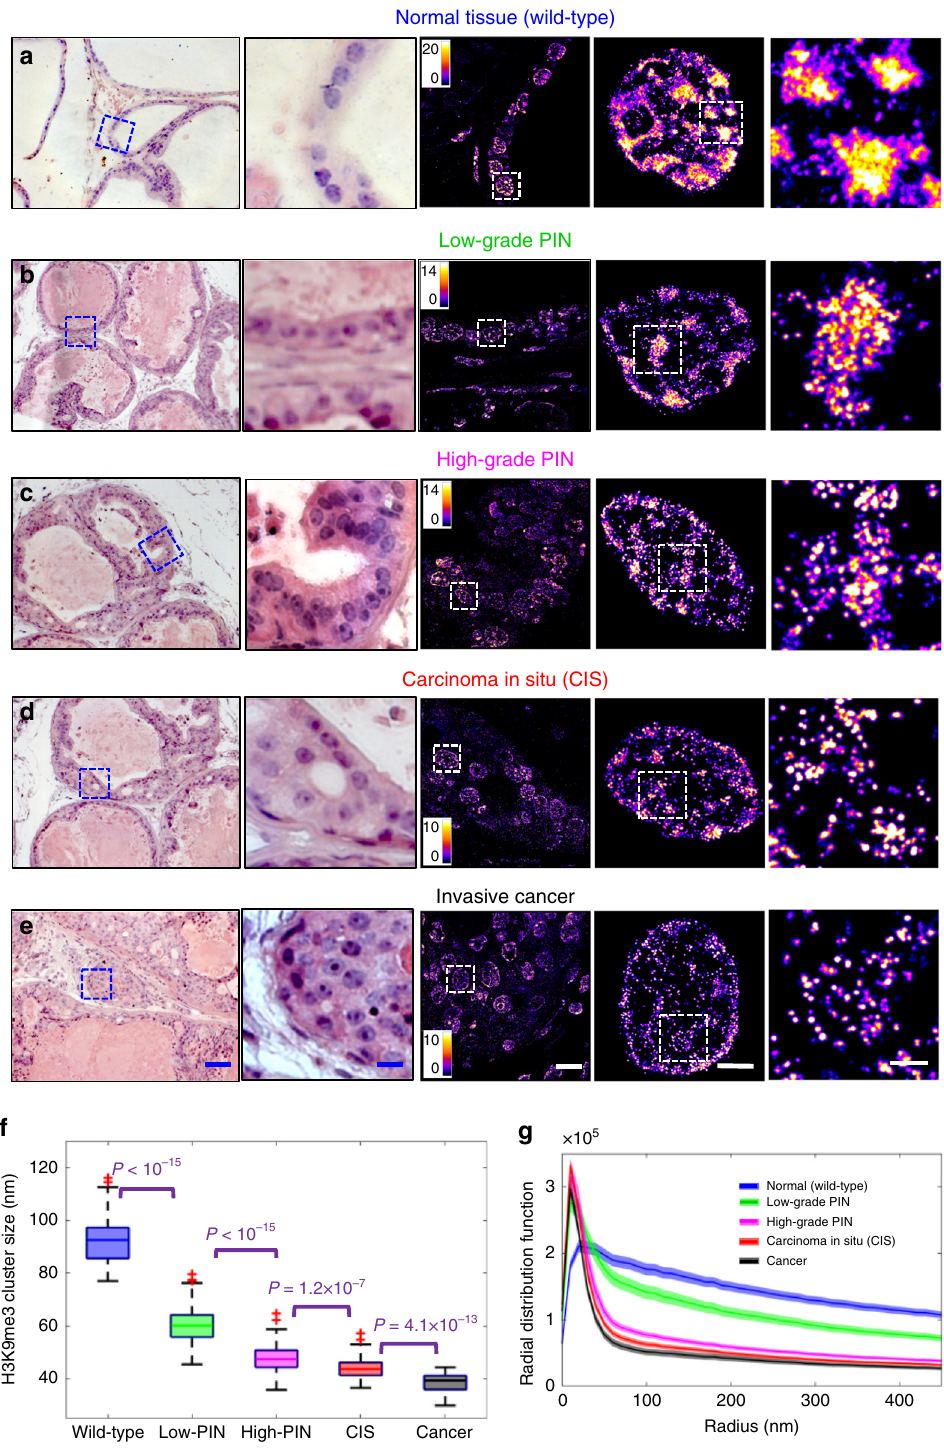
Fig. 5 Super-resolution imaging of disrupted heterochromatin structure in prostate neoplasia. a – e Representative histology and the corresponding super-resolution images of heterochromatin structure (from the blue boxes) from normal epithelial cells of the prostate from wild-type mice, low-grade prostate intraepithelial neoplasia (low-grade PIN), high-grade PIN, carcinoma in situ (CIS) and invasive prostate carcinoma from Hi- Myc mice. Scale bars in the H&E images are 200 and 10 µ m, respectively. Scale bars in the STORM images are 10 µ m, 2 µ m and 500 nm, respectively. f Box-and-whisker plot of the H3K9me3 cluster size ( n = 111, 72, 110, 86, 69 cells, respectively). Cell nuclei from three mice for each category were analyzed. g Radial distribution function (RDF) that quanti fi es H3K9me3-dependent heterochromatin structure, averaged over all nuclei for each group. The shaded area shows the standard error. The P value for wild-type vs. low-grade PIN, for low-grade PIN vs. high-grade PIN, for high-grade PIN vs. CIS and for CIS vs. cancer is P < 10 − 5 , P < 10 − 8 , P < 0.05 and P < 0.05, respectively. All P values were determined using Mann − Whitney